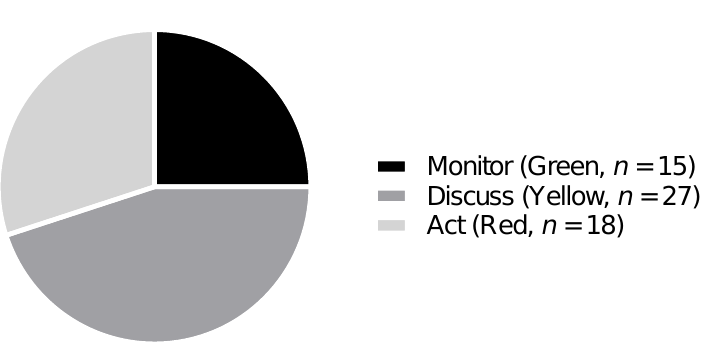
Figure 2. Distribution of MENTOR outcome in Hyogo Prefectural Central Rehabilitation Hospital ( n = 60). Green “Monitor”, Yellow “Discuss,” and Red “Act.”